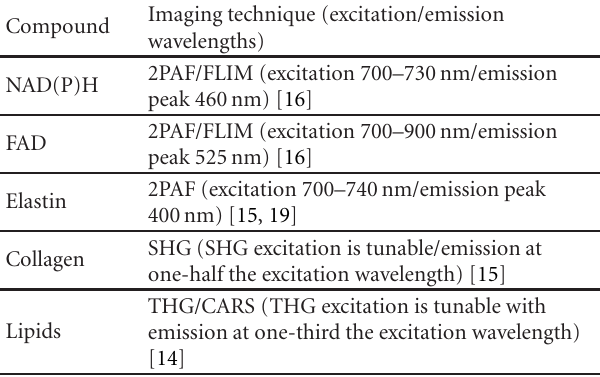
Table 1: Optimal imaging contrast mechanism for di ff erent biological